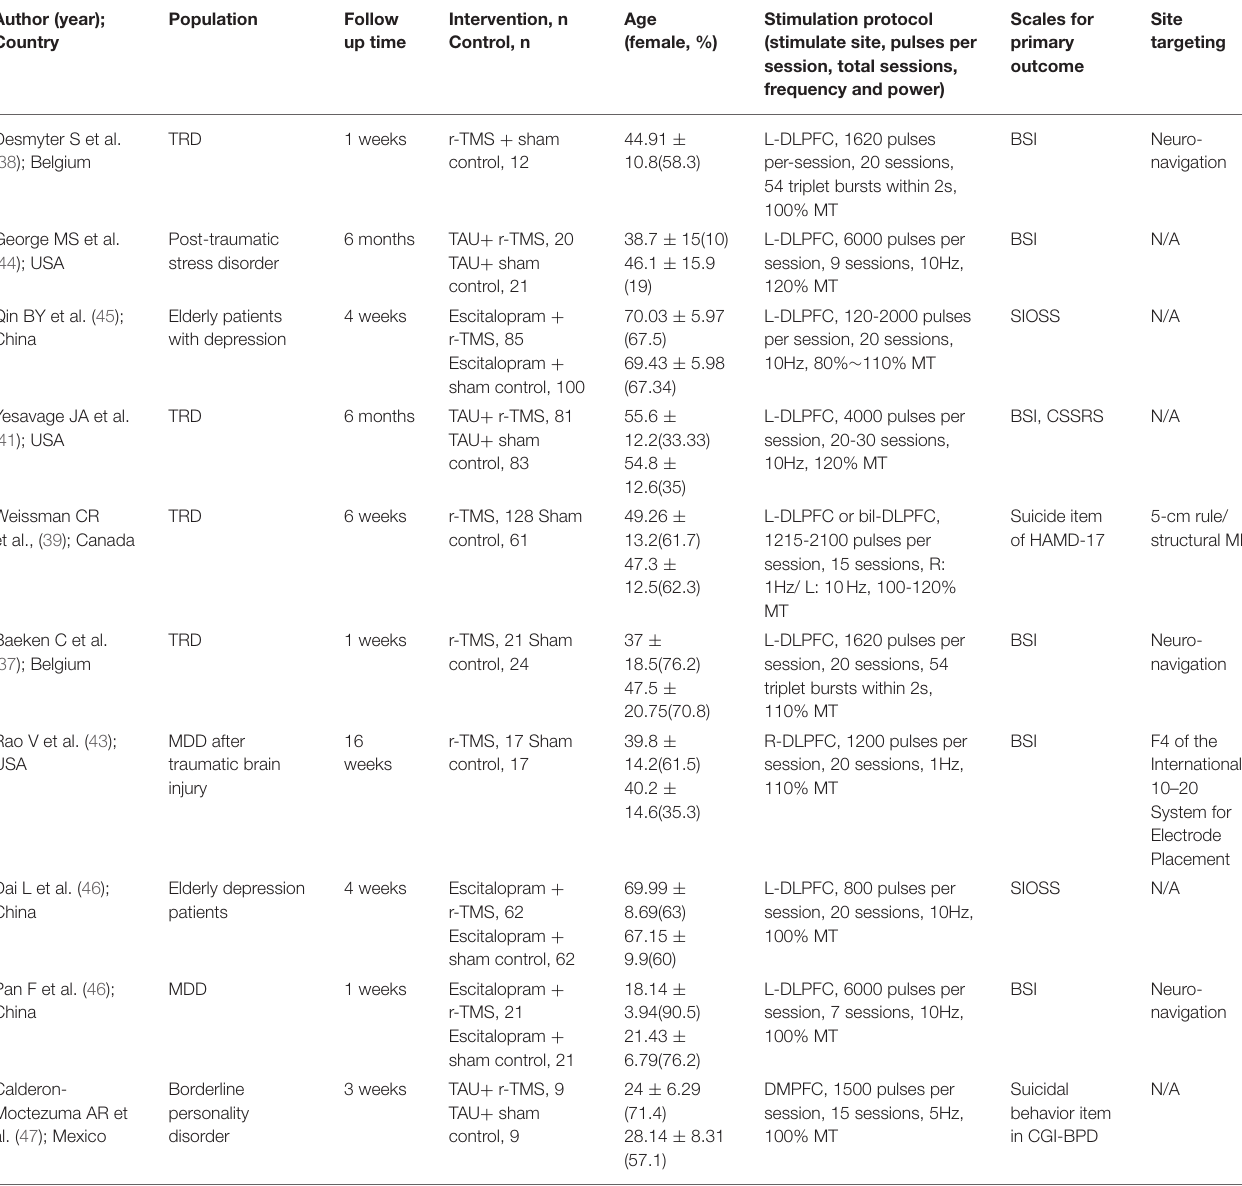
Population Follow